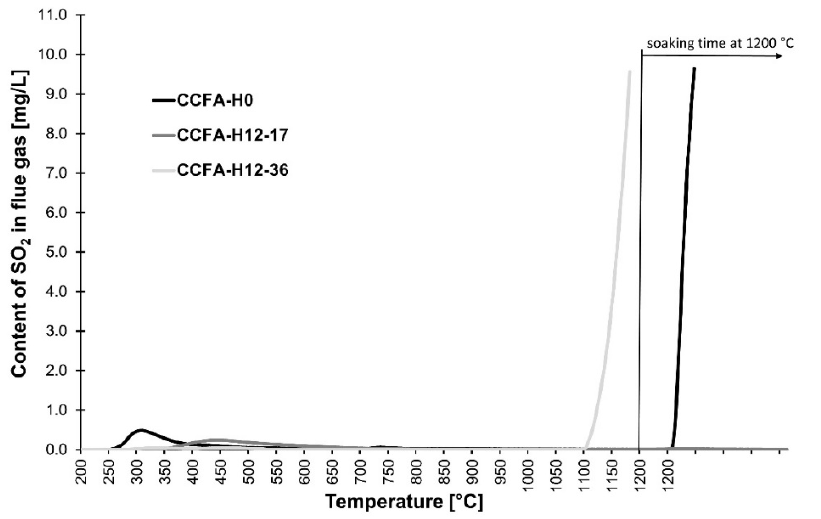
Figure 3. The content of SO 2 in the flue gas during the firing of test samples CCFA-H0, CCFA-H12-17, and CCFA-H12-36 depending on the firing temperature.